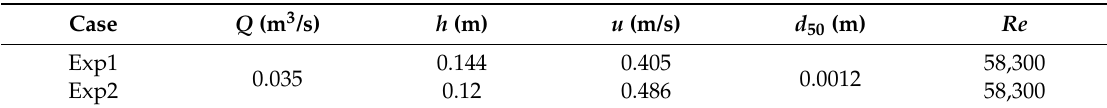
Table 1. Physical experiment set